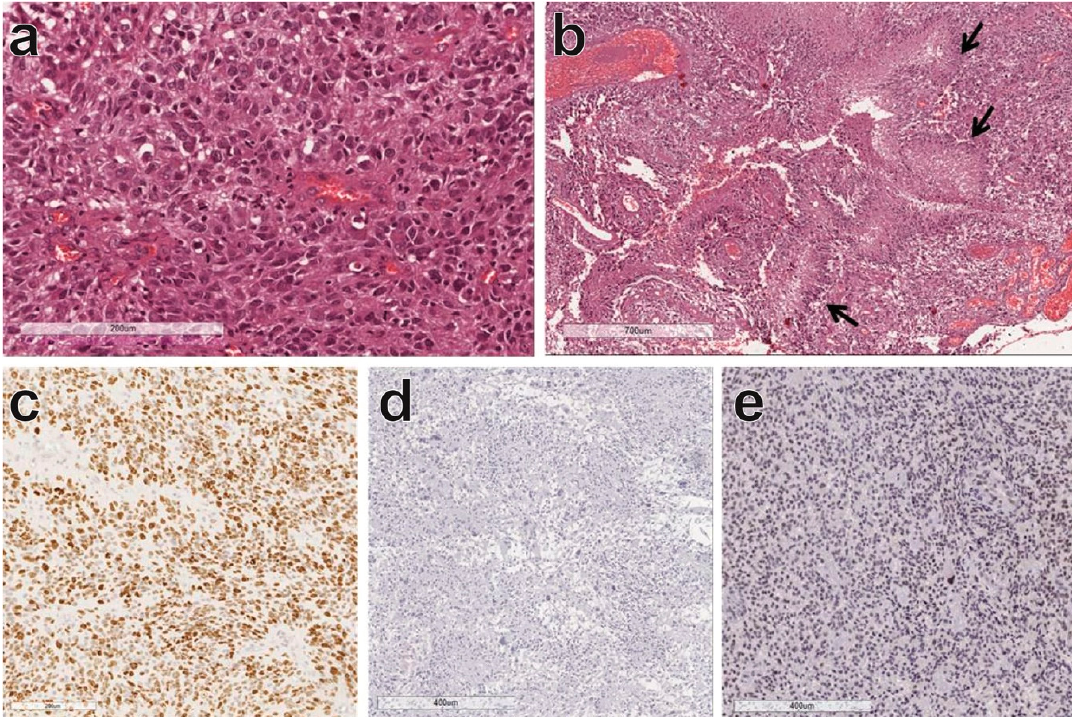
Figure 1. Glioblastoma, isocitrate dehydrogenase (IDH) wildtype. Highly anaplastic glial cells with nuclear atypia and pleomorphism ( a ); palisading necrosis (arrows) and microvascular proliferation